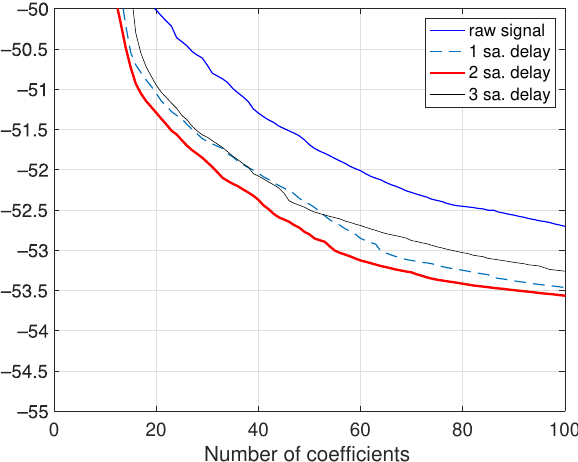
Figure 5. NMSE results of the bi-CKV models for different input–output alignments for a class AB power amplifier operated at 3.6 GHz with an average output power of 27.4 dBm. The NMSE is optimized with a delay of